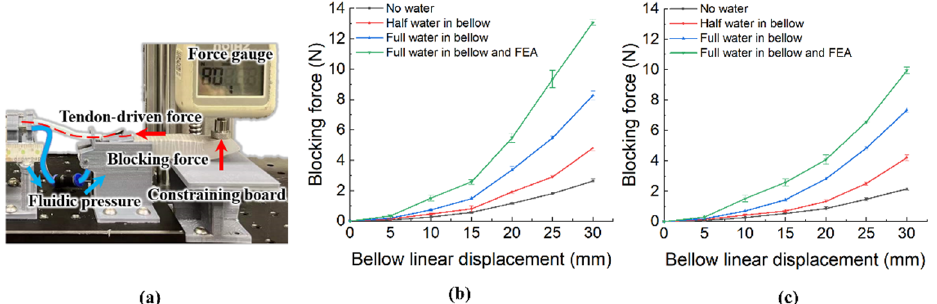
Figure 8. Blocking force test. ( a ) Blocking force test platform. ( b ) Blocking force of the DASA. ( c ) Blocking force of the FEA only. ( c ) Blocking force of the FEA